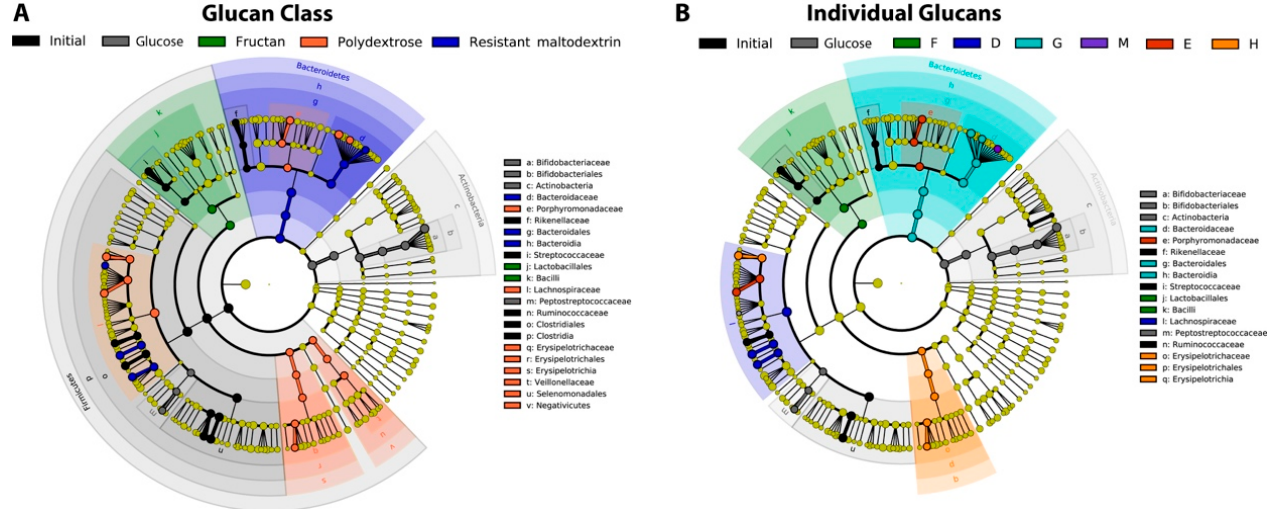
Figure 7. Linear discriminant analysis of bacterial taxa differentiating glucan classes ( A ) and glucans ( B ) (both LDA ≥ 3.5). Nodes represent different taxonomic levels increasing in taxonomic resolution (species on the outer ring). Resistant maltodextrins are depicted as shades of blue, and polydextroses as shades of orange. No significant associations of taxa with mixed linkage α‐ glucans were observed at this LDA threshold.